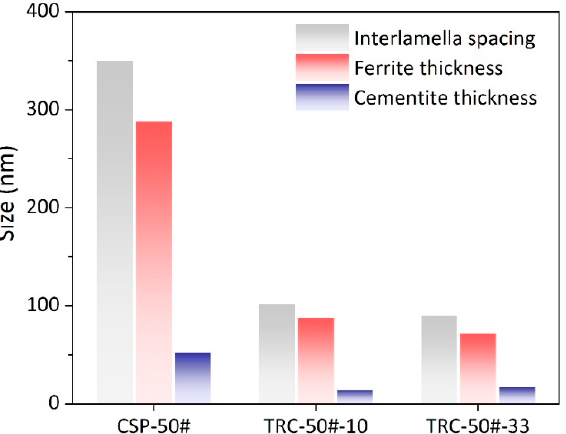
Figure 8. The statistics of the pearlite IS, the thickness of ferrite lamella, and the thickness of cement- ite lamella of the three hot-rolled strips with edge-on condition.